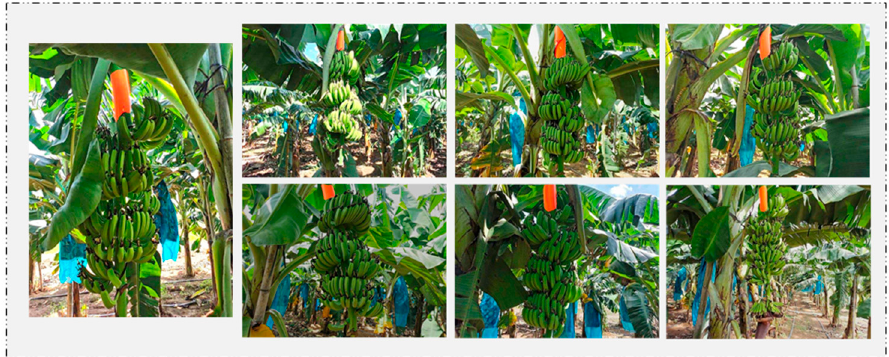
Figure 14. Segmentation effects of Sandglass_MFN network model.